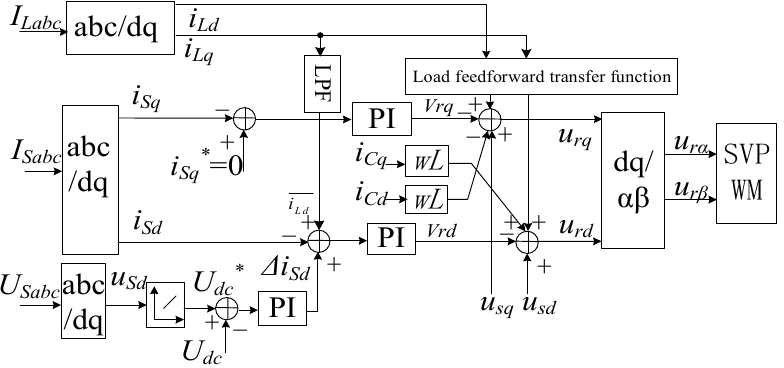
Figure 2. Control system diagram of APF based on source current direct control.